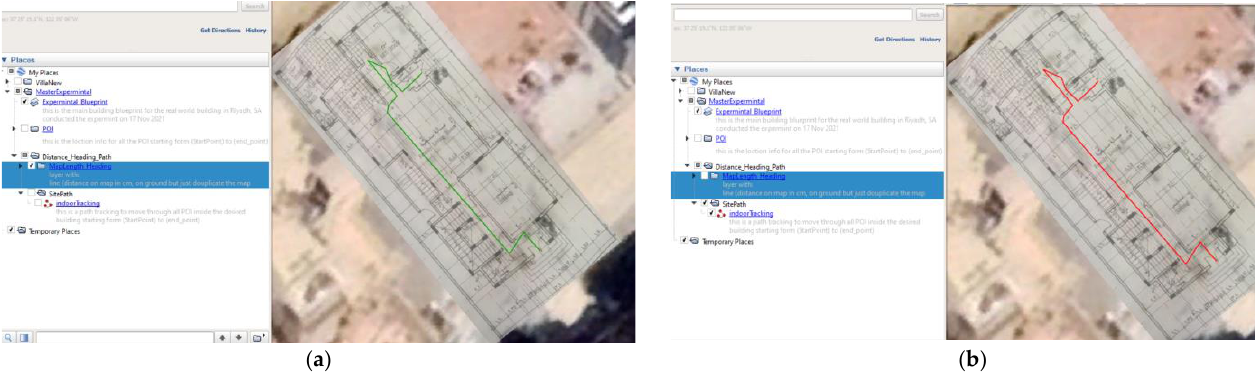
Figure 27. Moving and heading paths: ( a ) heading of moving; ( b ) moving path.